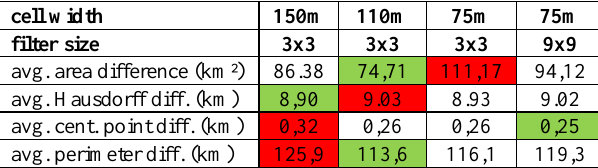
Table 1: Evaluation of the similarity of the integrated data with the reference data by evaluating different parameters.